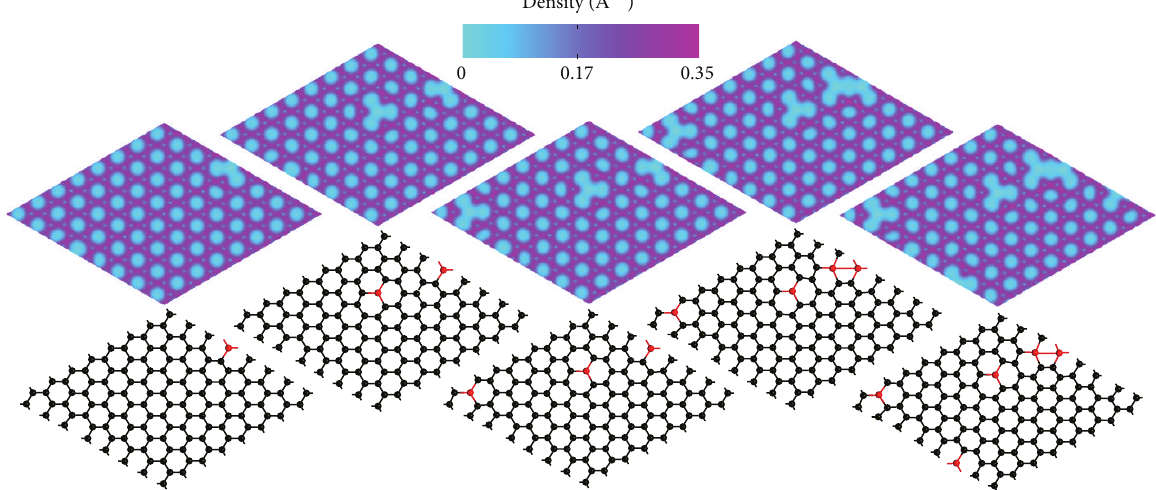
Figure 2: The calculated electron density as a function of spatial position in graphene with various concentrations of gallium (from left to right: 0.78, 1.56, 2.34, 3.13, and 3.90% Ga doping). The crystal structure is given directly below the density